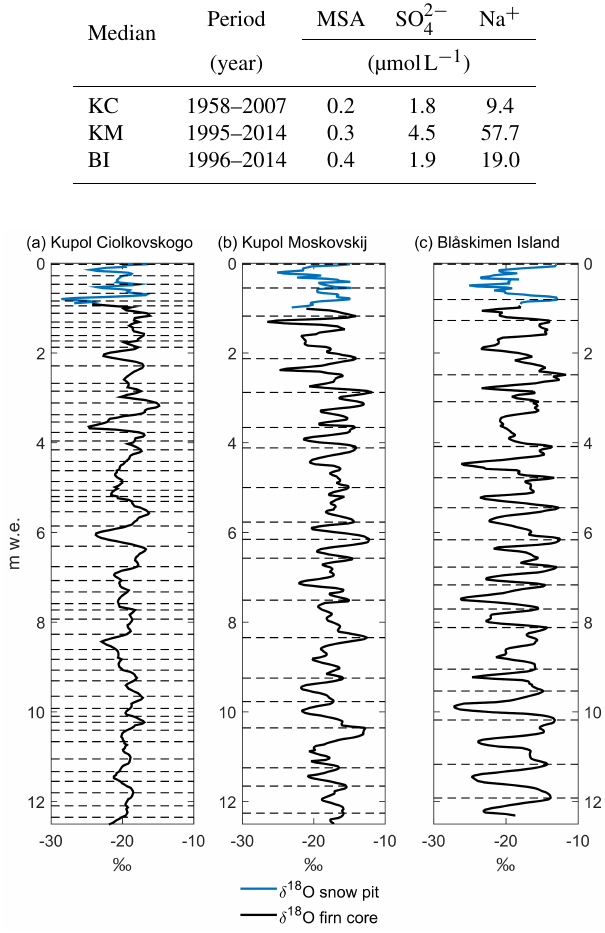
Figure 2. δ 18 O–depth profiles of (a) KC, (b) KM, and (c) BI. The blue lines indicate the δ 18 O values for the 2m snow pits at each core site. Seasonal variations are used to date the KM and BI cores; horizontal lines mark the summer maxima inferred in the KC core and identified in the KM and BI